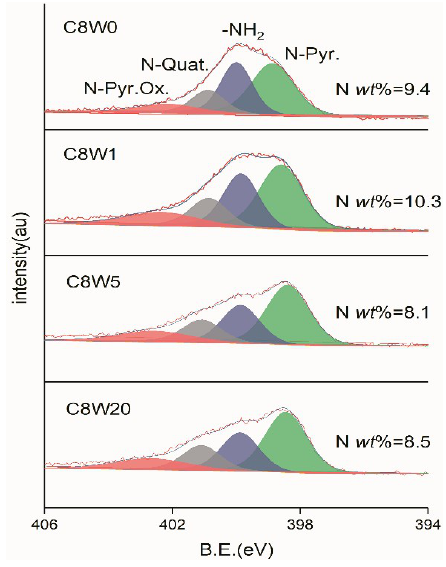
Figure 7. N1s XPS fitting curves of different microwave processing durations.